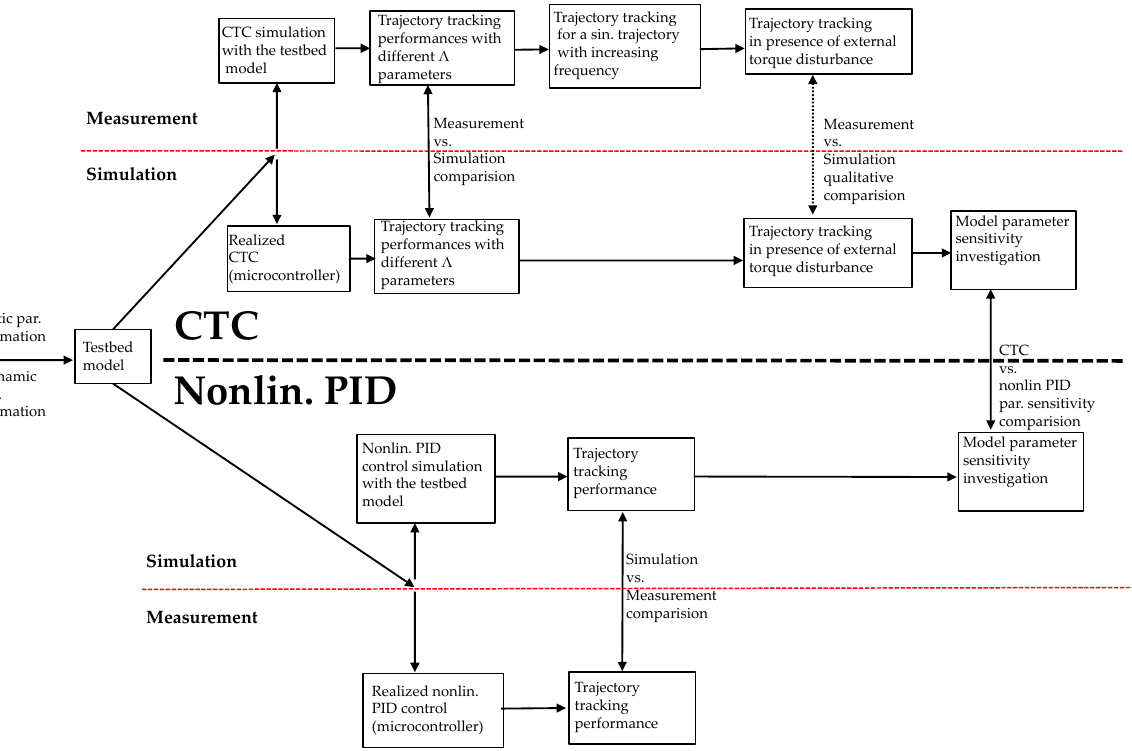
Figure 2. Block diagram of the methodology used in the